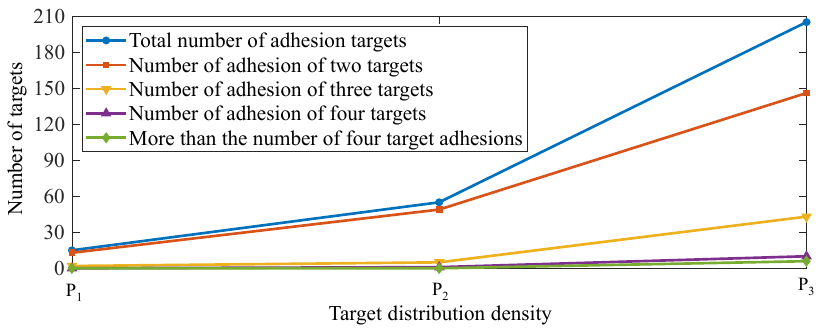
Figure 15. Distribution of adhesion targets.